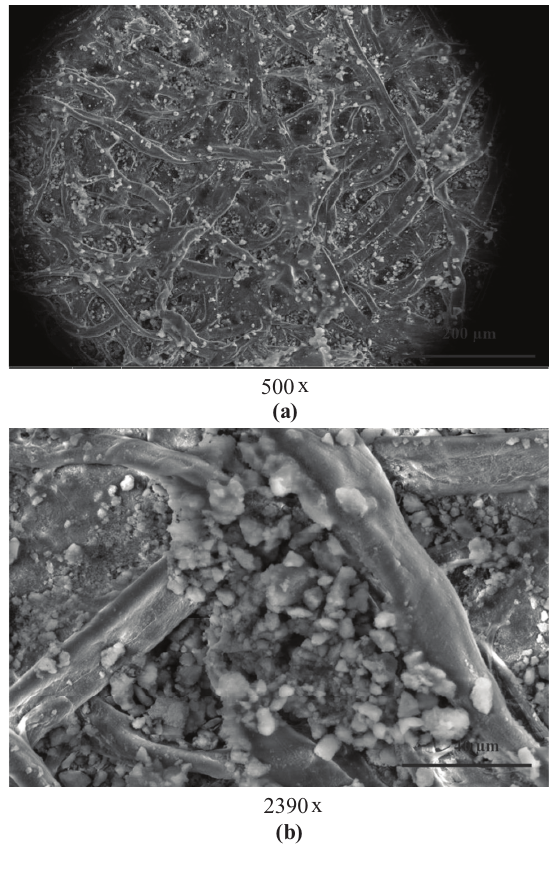
Figure 2. (a) and (b) SEM